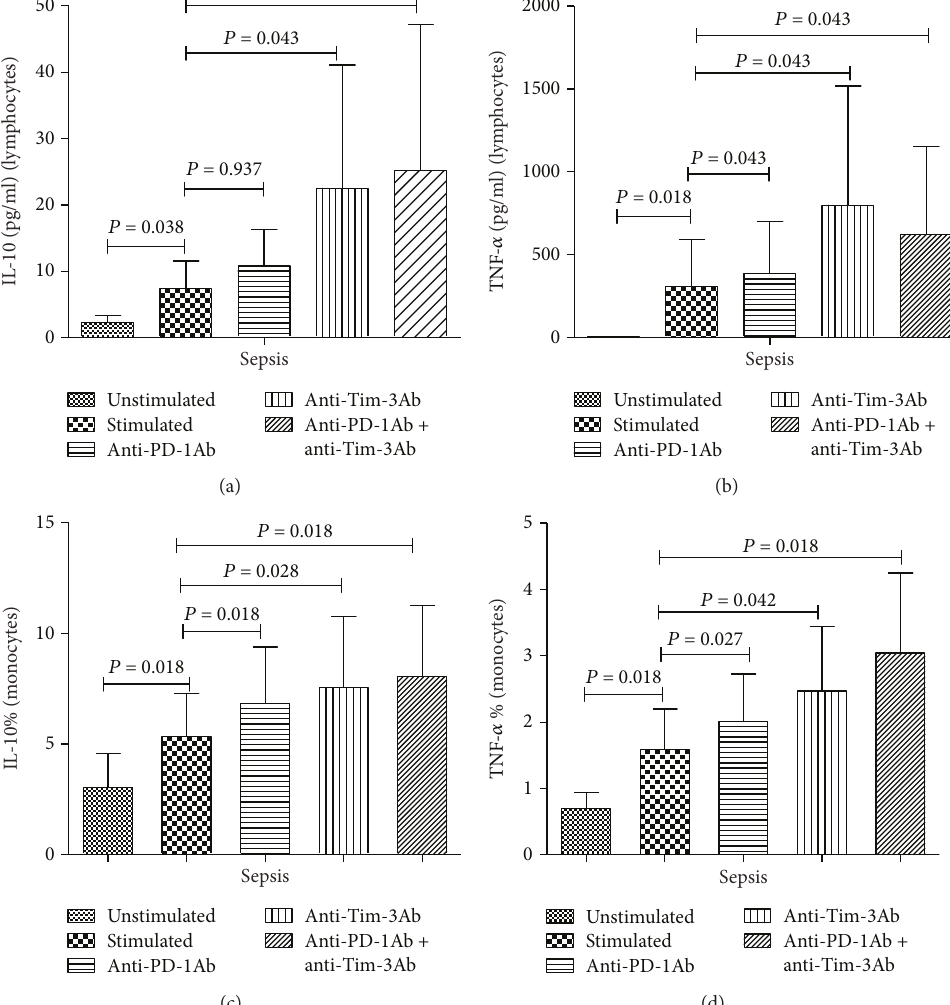
Figure 3: E ff ects of the Tim-3 and PD-1 signaling pathway on the cytokines in the T lymphocytes and monocytes. (a) Expression of IL-10 in T lymphocytes after Tim-3 and PD-1 blockade. (b) Expression of TNF- α in T lymphocytes after Tim-3 and PD-1 blockade. (c) Proportion of IL-10-expressing monocytes after Tim-3 and PD-1 blockade. (d) Proportion of TNF- α -expressing monocytes after Tim-3 and PD-1 blockade. The data were analyzed by the Mann – Whitney